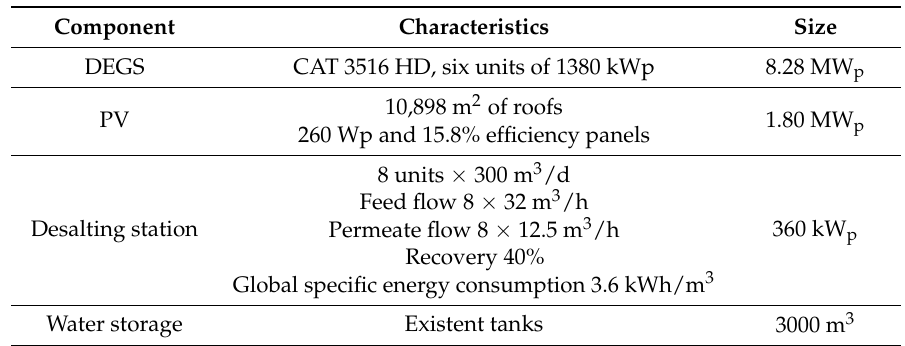
Table 2. Main technologies